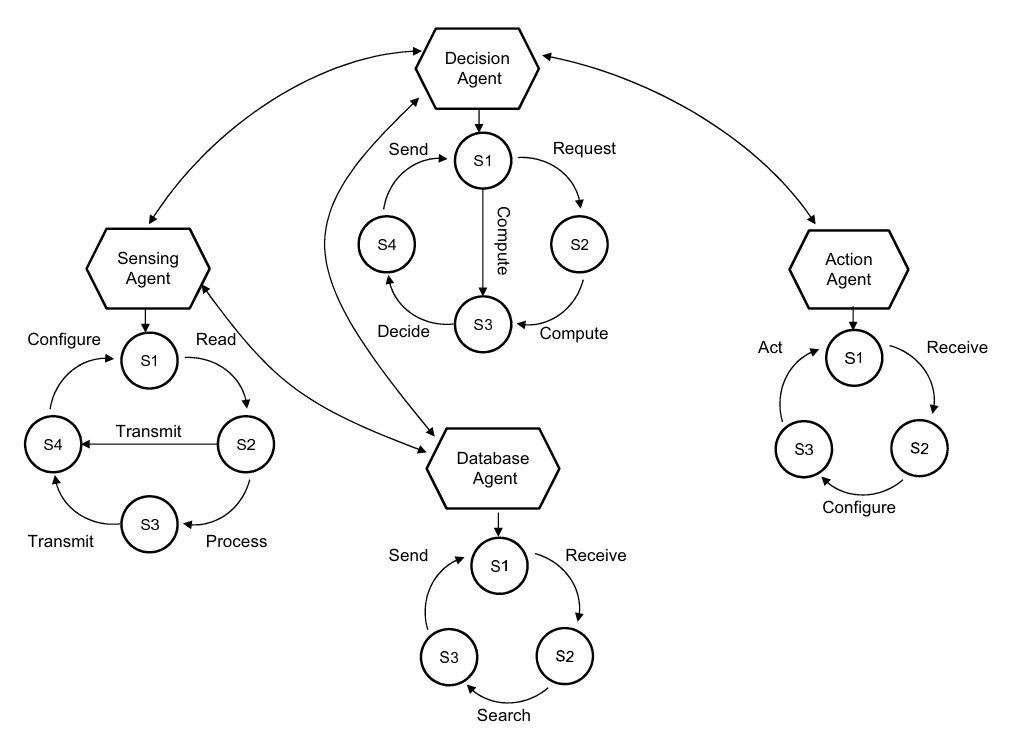
Figure 7. The architecture of a multi-agent system and the finite states of each